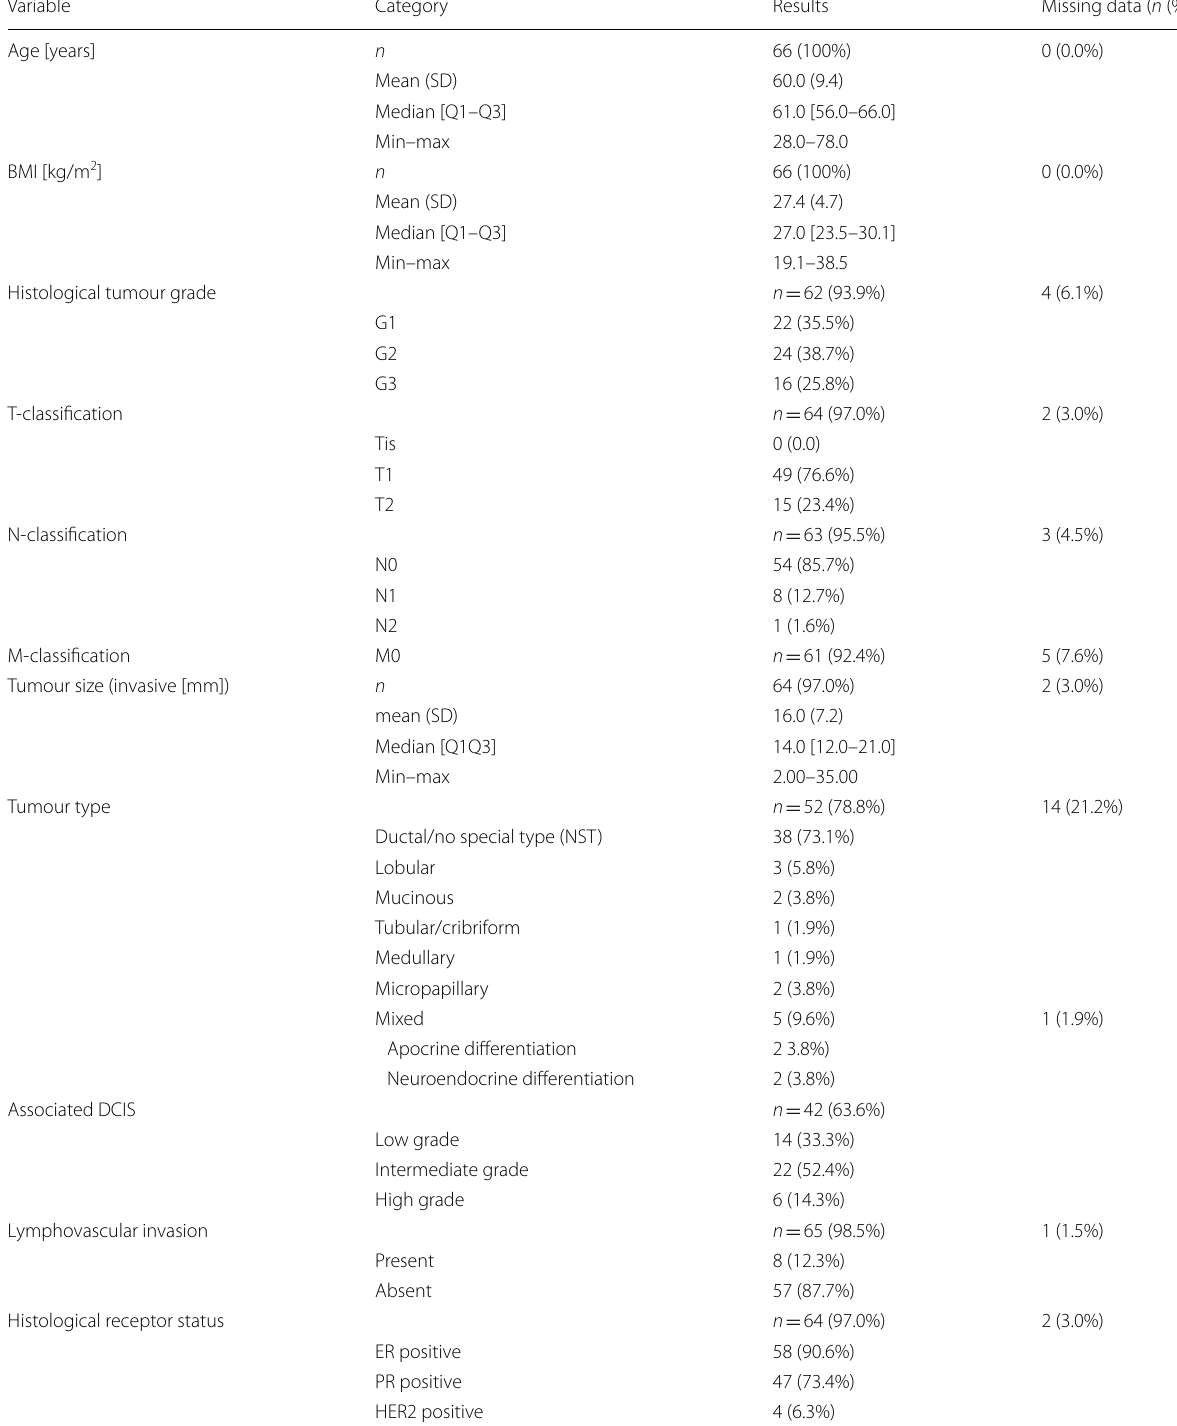
Table 1 Patient demographics and tumour